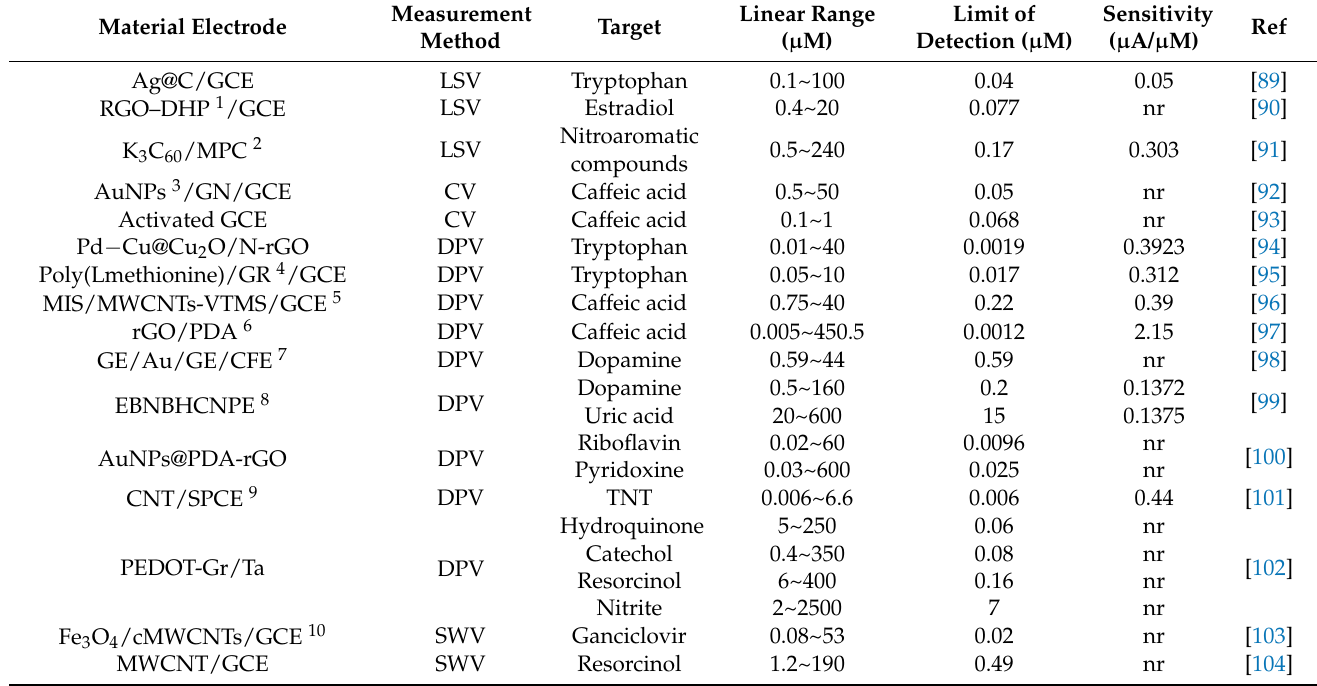
Table 1. Carbon material, their variation and performance in detecting